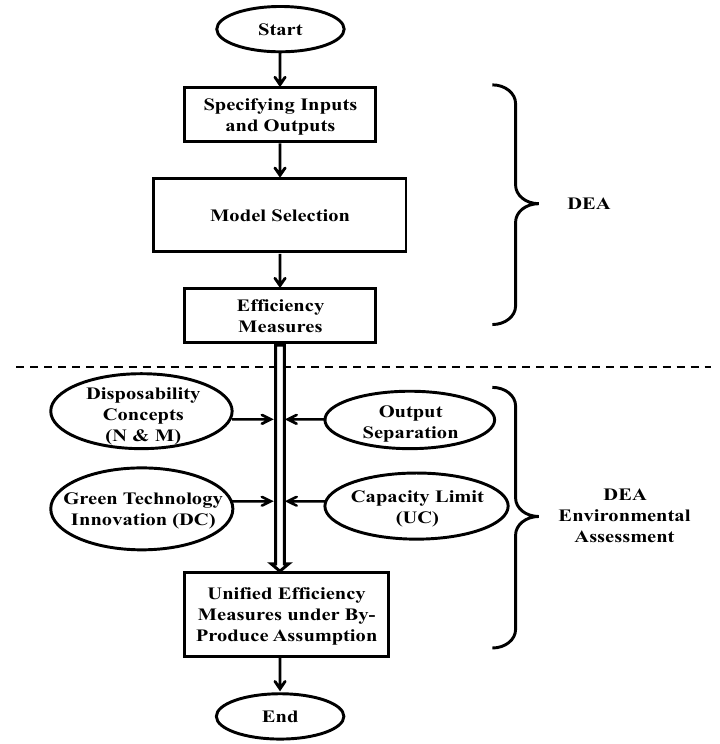
Figure 3. A conceptual flow incorporated into environmental assessment. (a) The upper part visually describes that DEA starts with specifying X and G . Then, it determines which models are used for the proposed research. The process excludes B . The part depicts a conventional use of DEA that assesses the performance of DMUs. (b)The lower part depicts how new proposed concepts are included into the proposed assessment. The process distinguishes between G and B . The separation needs two disposability concepts (i.e., N and M) for the unification between them. Then, we incorporate equality constraints on G or B to identify a potential of green technology innovation or that of a capacity limit on a production system, respectively. We also incorporate the new assumption that B is the by-product of G. Finally, the assessment produces three unified efficiency measures under the two disposability concepts and the by-product assumption.